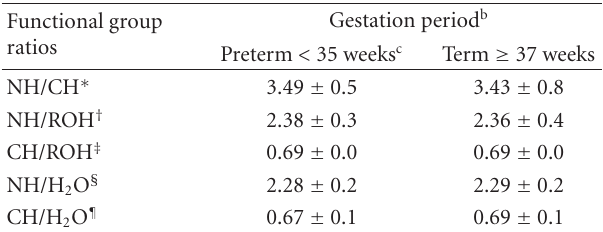
Table 3: Means and standard deviations by functional groups for term and preterm births a